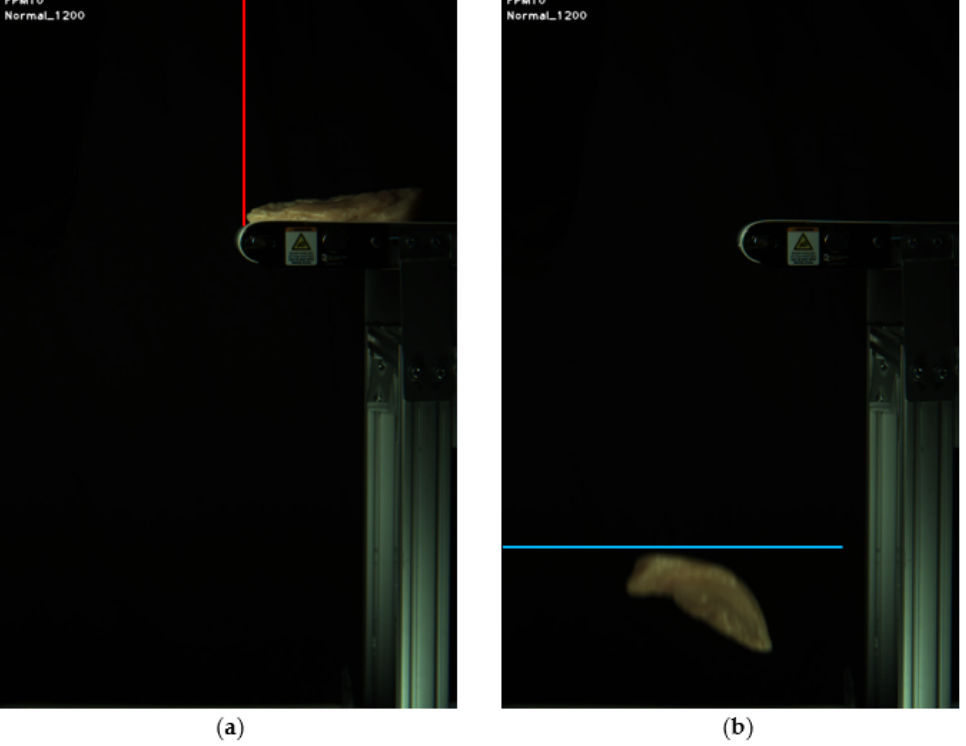
Figure 4. Software motion sensing trigger lines for detecting ( a ) new arrival (a vertical line) and ( b ) departure (a horizontal line) of a fillet for tracking and analysis.